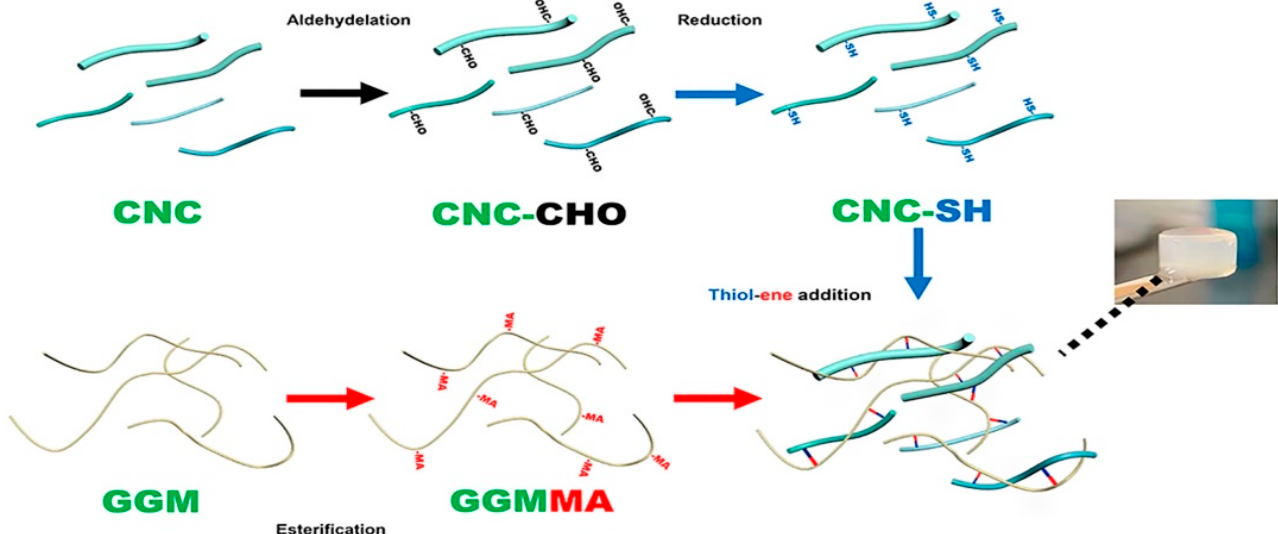
Figure 14. Fabrication of GGMMA/CNC-SH hydrogel via photo-initiated thiol- ene addition between GGMMA and CNC-SH (adapted with permission from Wang et al., 2022).